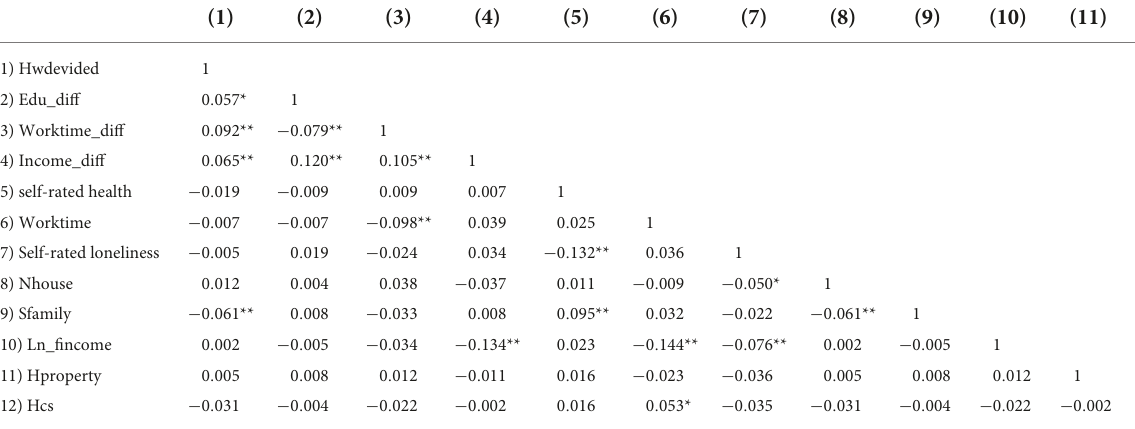
TABLE 2 Descriptive statistics and correlations among all variables.